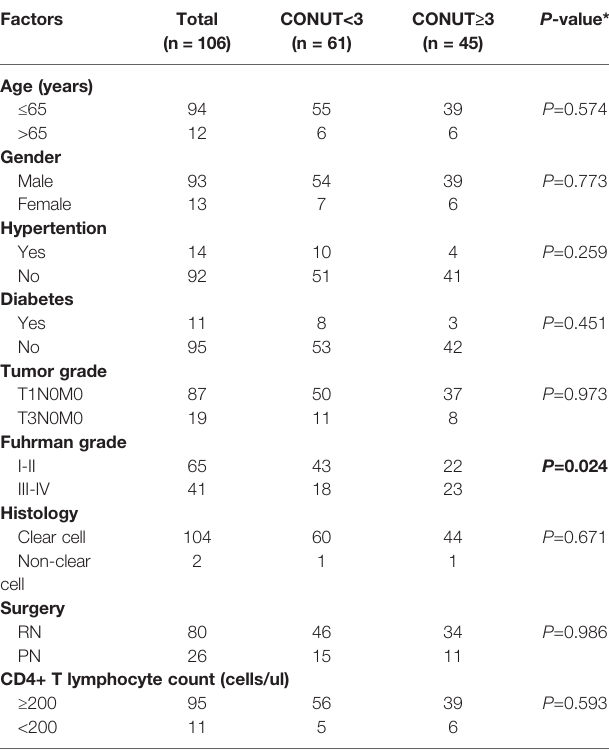
*Chi-square test. Bold value indicates statistical signi fi cance in univariate and multivariate analysis which had been detailed in the “ Results ” section. RN, radical nephrectomy; PN, partial nephrectomy.